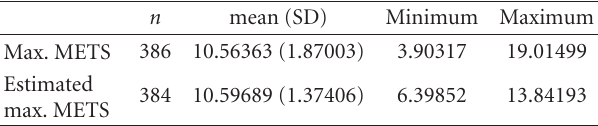
Table 3: Estimated Cardiorespiratory fitness (maximal achieved METS) and actual maximal METS in testing set ( n =